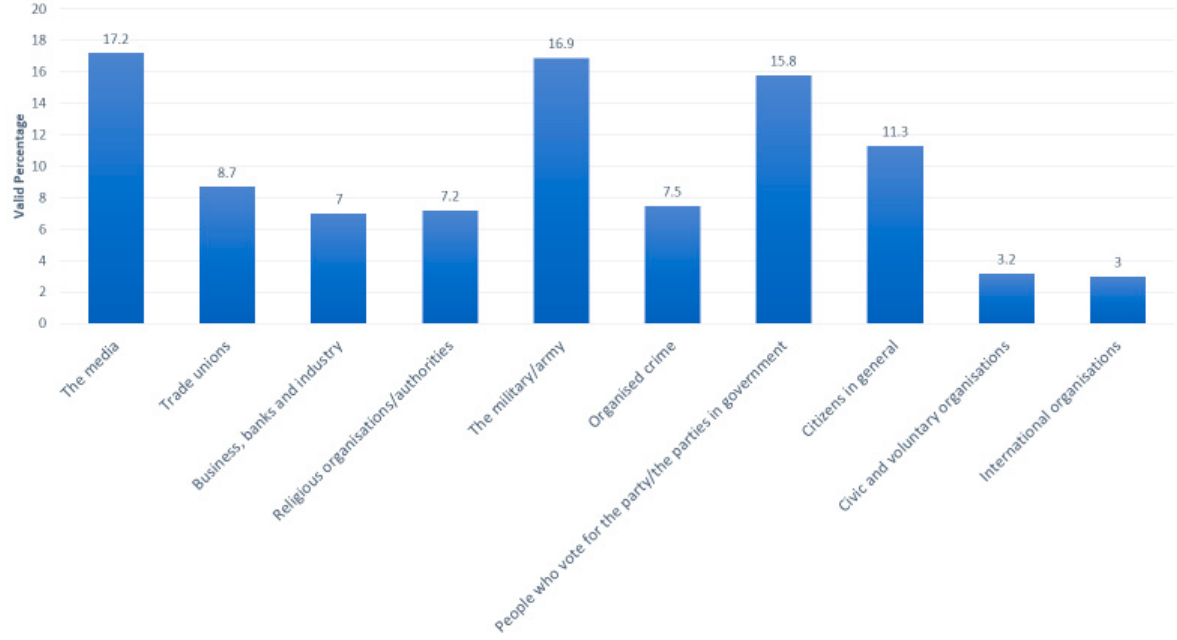
Figure 2. Percentage of responses suggesting that a group had the second most influence on the government.